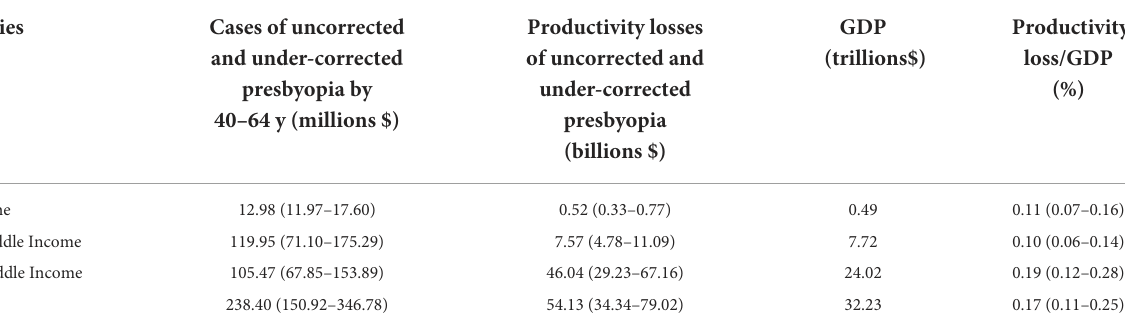
TABLE 1 Productivity losses of presbyopia in LMICs in 2019.